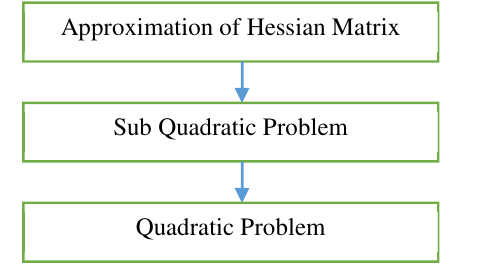
Fig. 2: Sequential Quadratic Programming